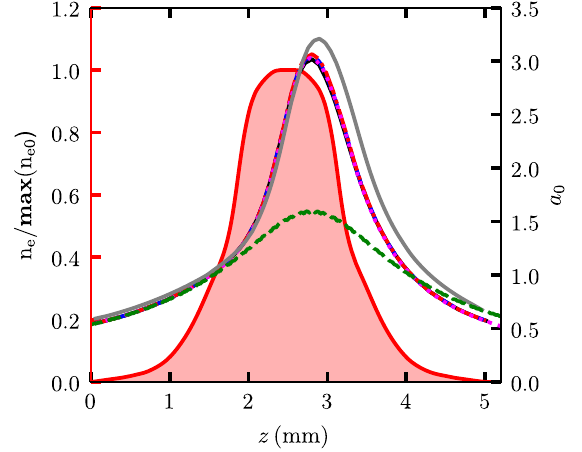
FIG. 2. Electron density profile along laser propagation axis (left vertical axis, red curve and shaded area), identical to the black solid curve in Fig. 1(c). Evolution of a 0 ð z Þ along propa- gation axis z (right vertical axis) in vacuum (green dashed line) and in plasma at different C : 2% (black solid line), 1% (blue N 2 dashed line), 0.5% (red dashed-dotted line) and 0.35% (magenta dotted line). The gray solid line represents the evolution of a 0 ð z Þ with respect to the propagation axis z for slightly different laser parameters, beam waist 17 μ m and focal position at 2.9 mm, discussed in Sec.